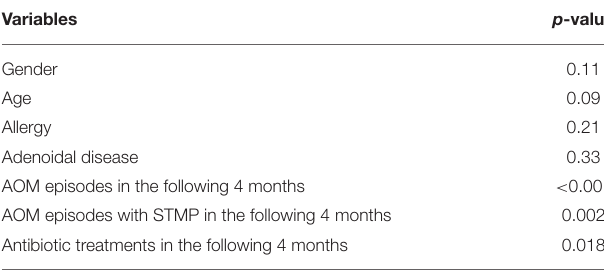
TABLE 4 | Results of multivariate logistic regression